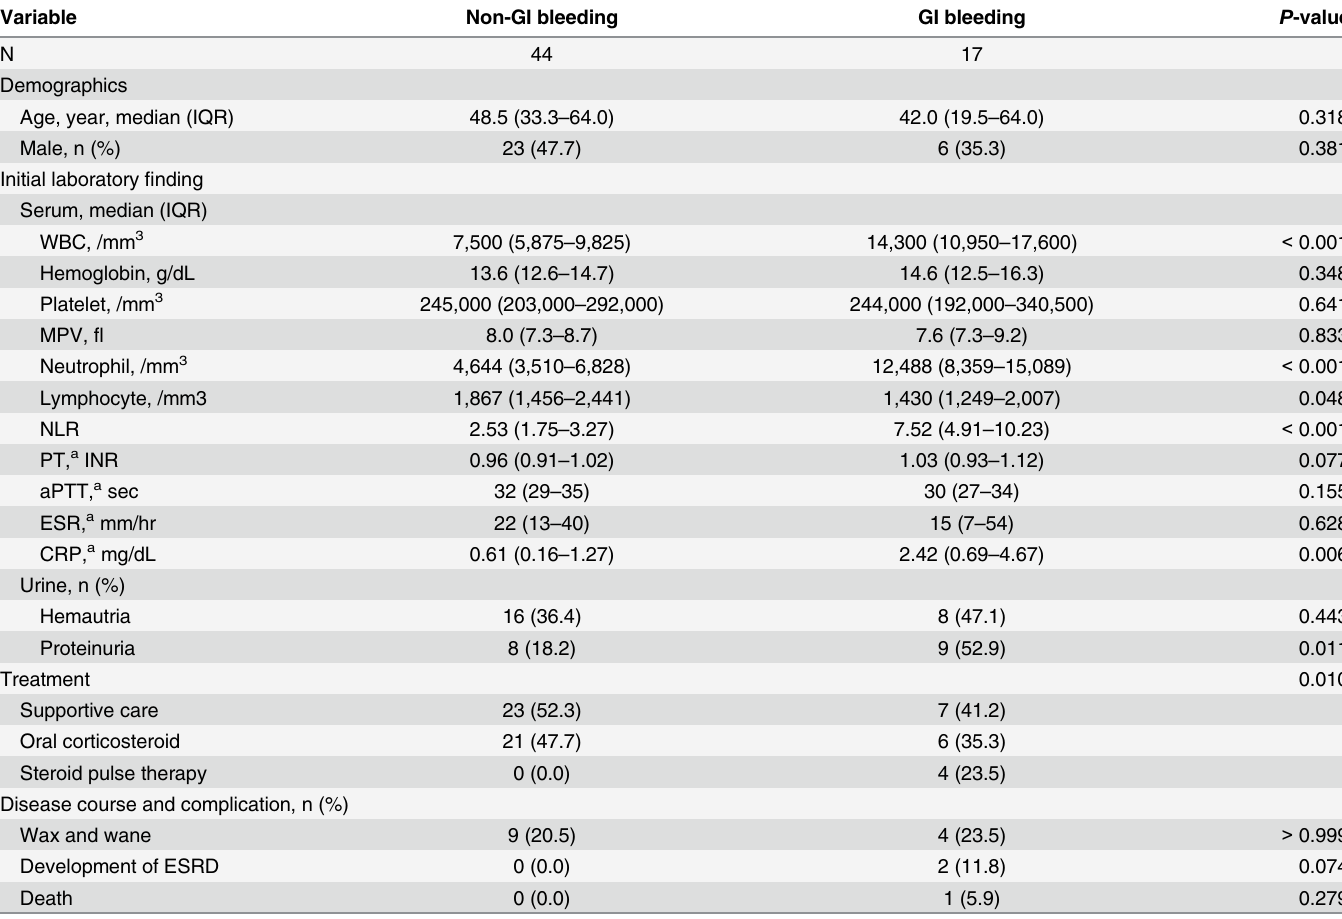
Table 2. Demographics, laboratory findings, and clinical course of the patients according to the gastrointestinal